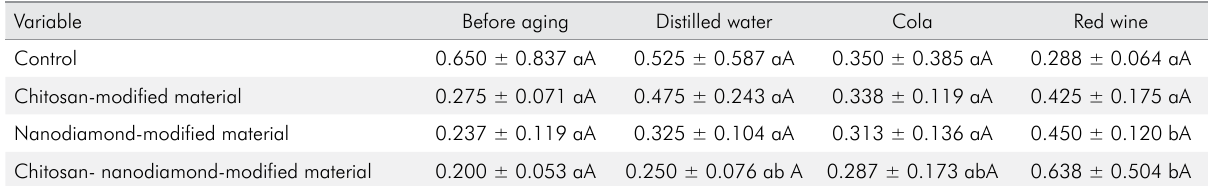
Table 3. Results of the Rz surface roughness of the materials before and after aging in different solutions.